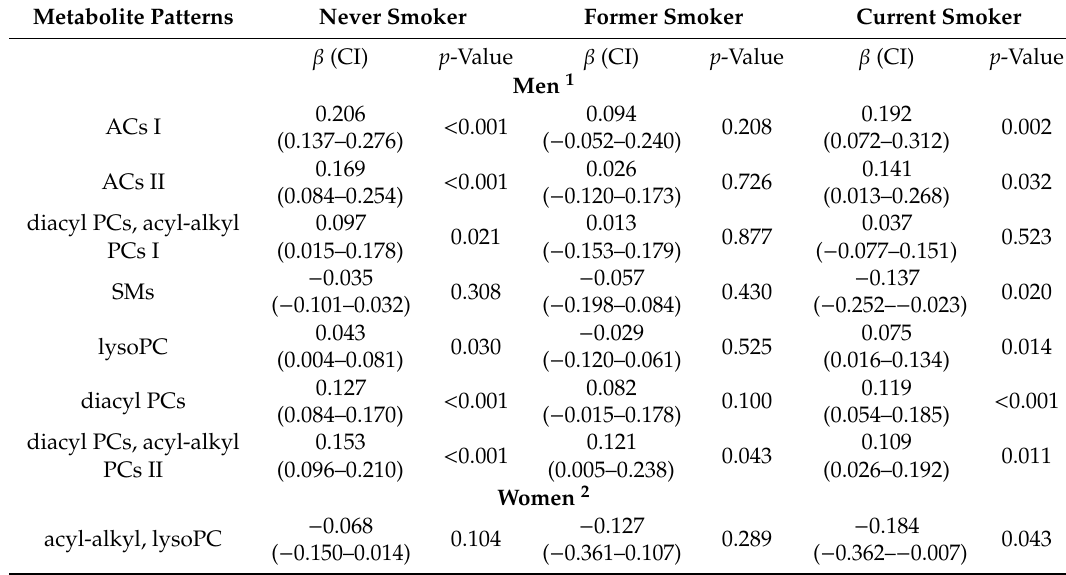
Table 3. Linear regression models stratified by smoking status in men and women at the time of recruitment (1994–1998) in